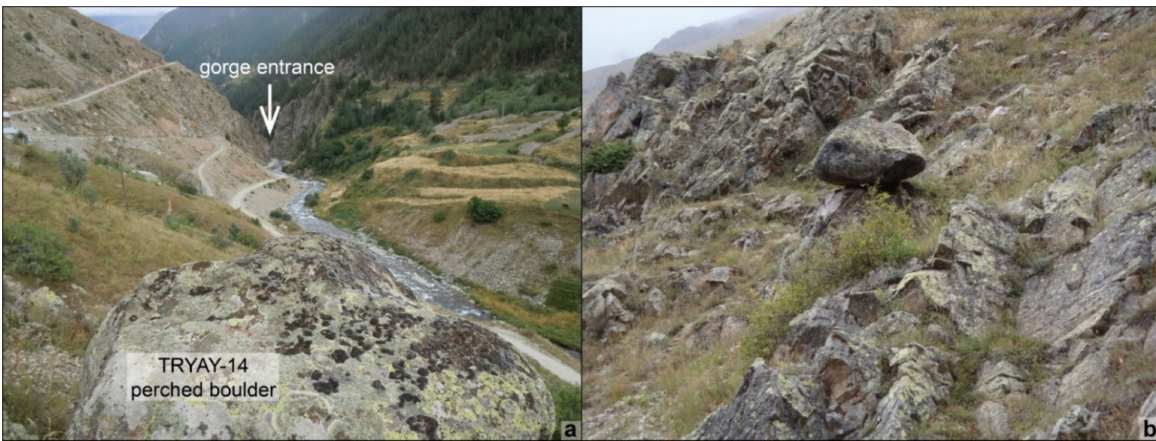
Figure 3. ( a ) View from boulder TRYAY-14 down-valley towards the gorge entrance and to the most likely ice-contact terrasses. The gorge entrance is interpreted based on the morphology and on the reconstruction of lateral ice margins (Figure 4) as the approximate LGM glacier terminus. ( b ) The perfectly perched erratic boulder TRYAY-14 (map position see Figure